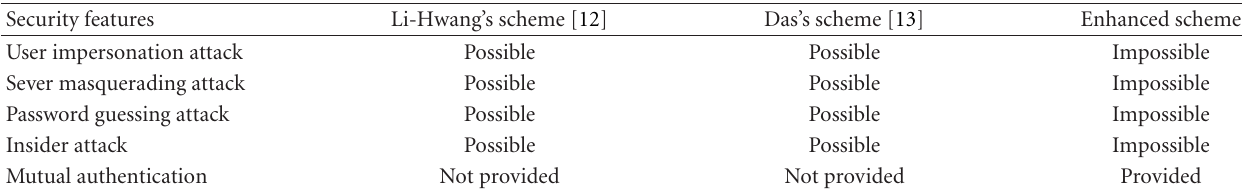
Table 2: Security comparison of the related scheme and the enhanced